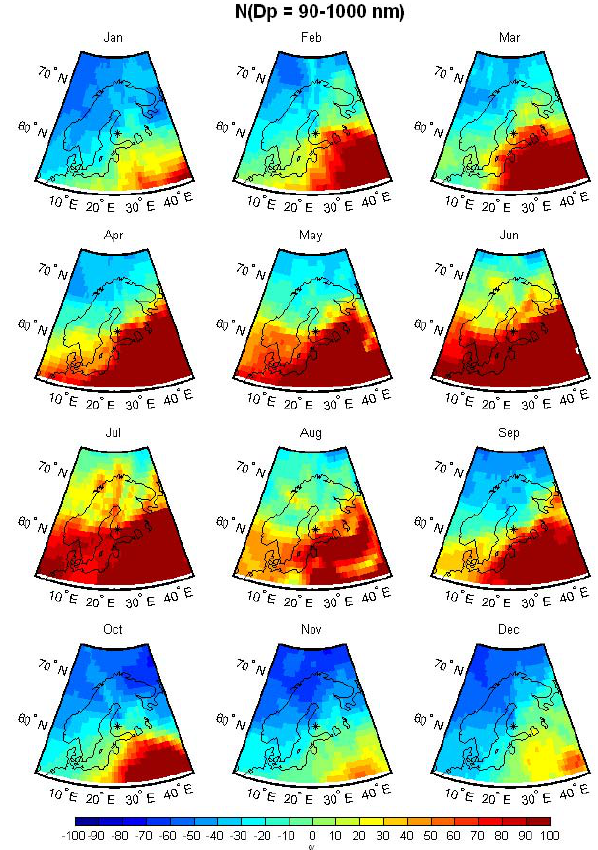
Fig. 4. Deviation from measured average number concentration of accumulation mode particles ( D p = 90–1000nm) in Hyyti¨al¨a ac- cording to transport directions. Monthly concentration fields are produced for years 1996–2008. Fields are normalized to the geo- metric mean concentration (419 cm − 1 ) of the whole measurement period. Hyyti¨al¨a is marked with a